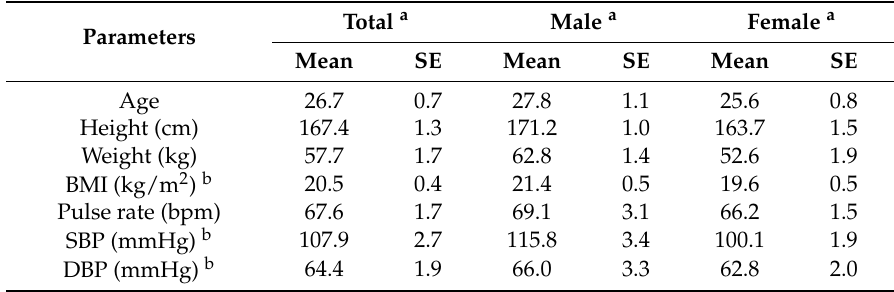
Table 1. Baseline values of the